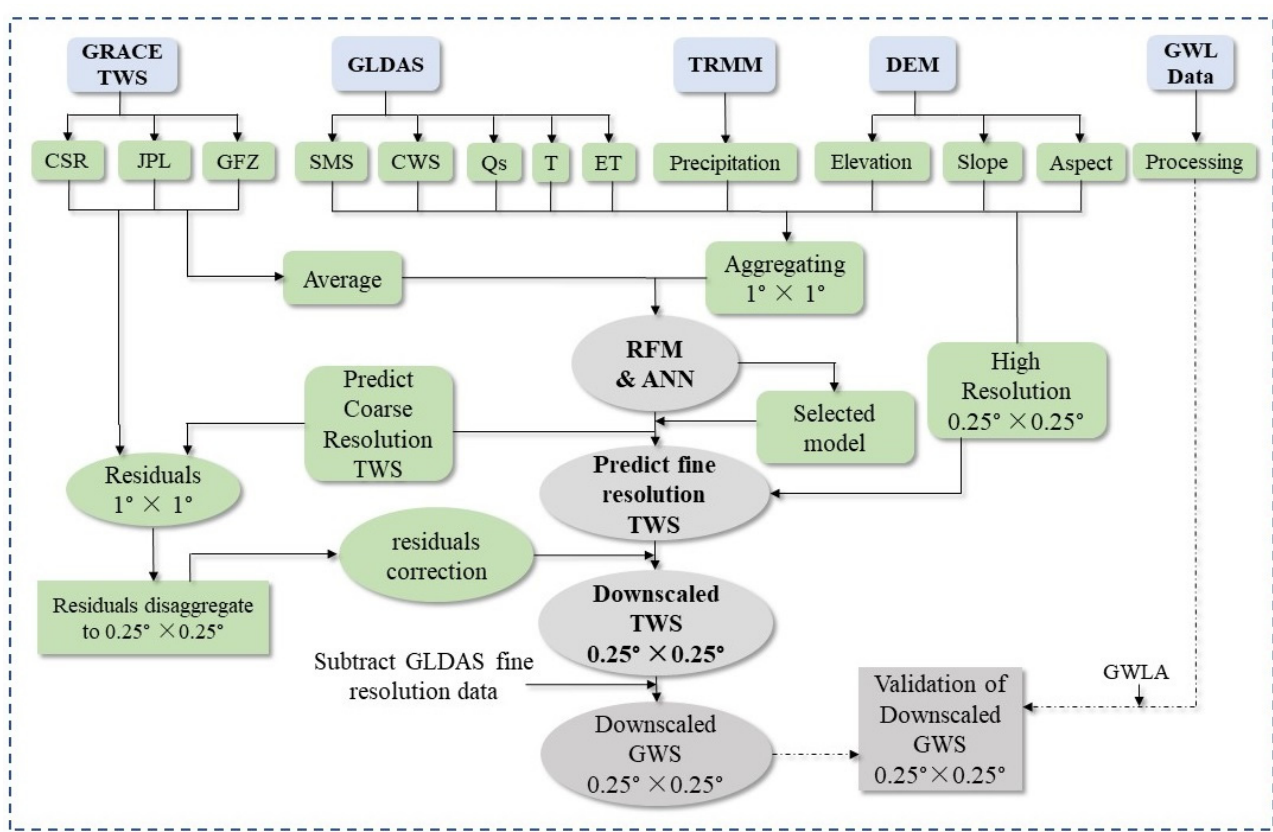
Figure 3. Flow diagram of an integrated downscaling process in the current study.